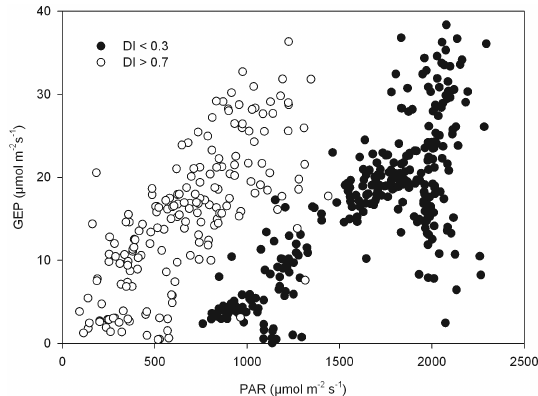
800 to 1350 µmol m − 2 s − 1 ) indicated that, in the Monte Bon-